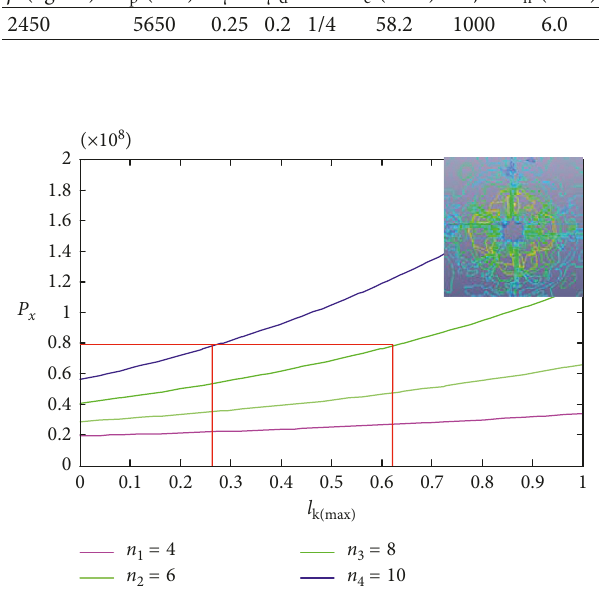
Figure 9: Effect of expanding medium pressure on crack development.